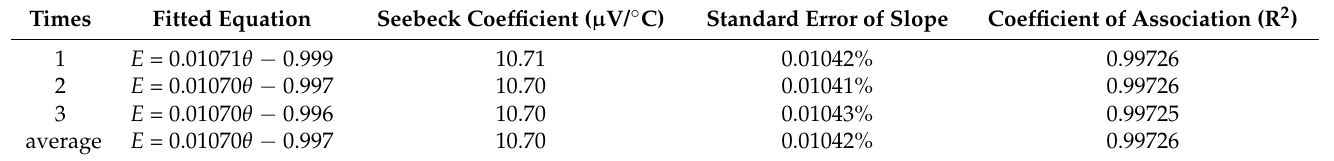
Table 2. Thermocouple static calibration data fitting results.